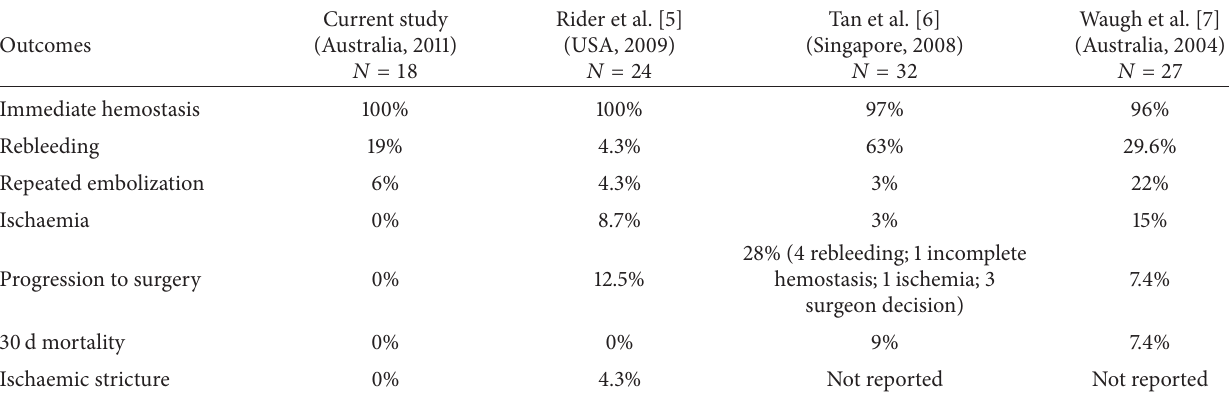
Figure 4: Super-selective embolization: (a) before and (b) after coil deployment. Table 2: Comparisons of outcomes with other